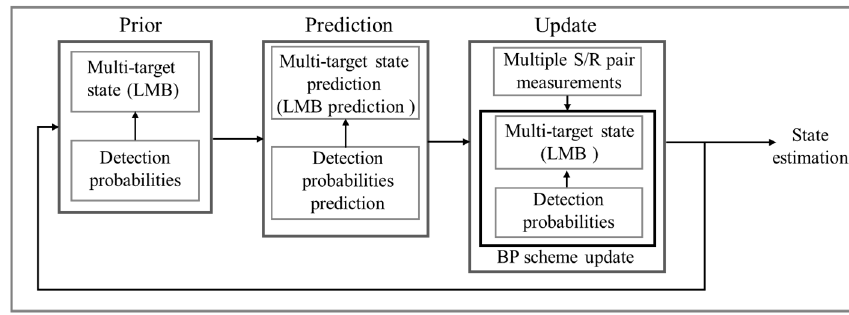
Figure 4. Block diagram of the R-MS-LMB fi lter.